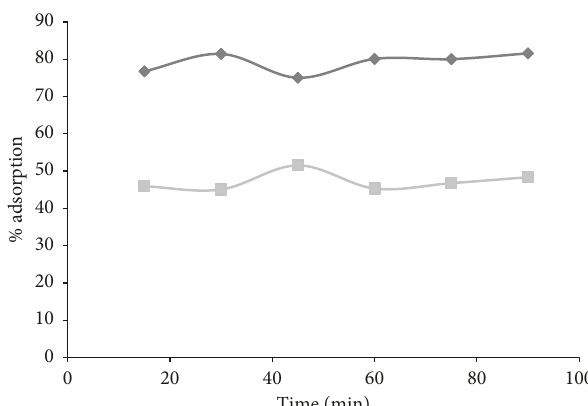
Figure 4: Graphical illustration of contact time effect on BG and AO-74 dyes removal by PR